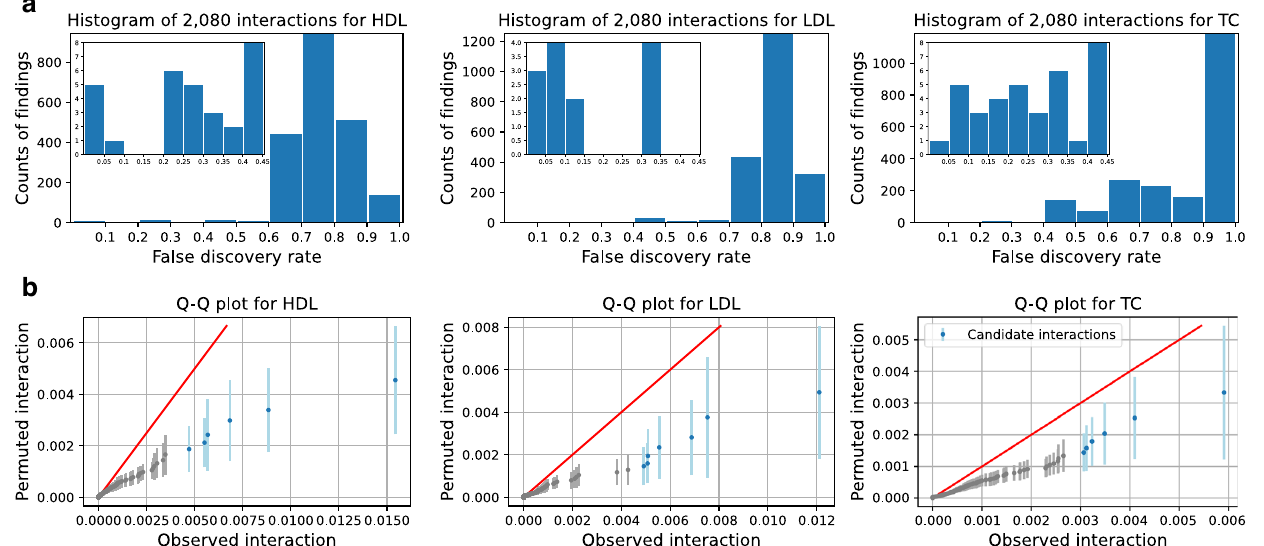
Fig. 6 Statistics of gene – gene interactions detected by NNs in a cholesterol study with the UK Biobank dataset. a The histogram of interactions for different false discovery rates (FDR). The inner panel zooms into FDR < 0.45 region. Each bar represents how many more interactions we will consider as positive if we increase FDR; e.g., 6 more fi ndings are included by increasing FDR from 0.20 to 0.25 for HDL. b The Q-Q plot of Shapley interaction scores on observed vs. permuted data. The bars cover 95% of interaction scores under the null hypothesis. We observe that top candidate interactions (blue, with FDR < 0.1) clearly deviate from the null distribution. Table 1 Candidate interactions detected by NNs in the real-world cholesterol study.